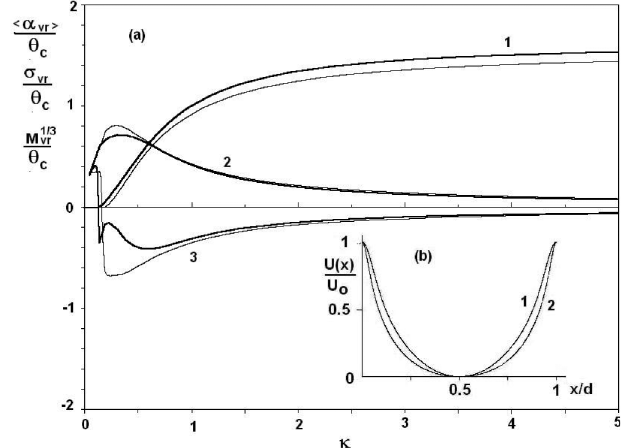
FIG. 10. The main characteristics of volume reflection for (cid:5) s positive particles. (a) Values h (cid:5) functions of the generalized parameter (cid:12) for (110) planes of silicon and tungsten single crystals (the thin and thick curves 1, 2, and 3, correspondingly); (b) normalized potentials U (cid:1) x (cid:2) =U the (110) plane in silicon (1) and tungsten (2) as functions of the relative coordinate.